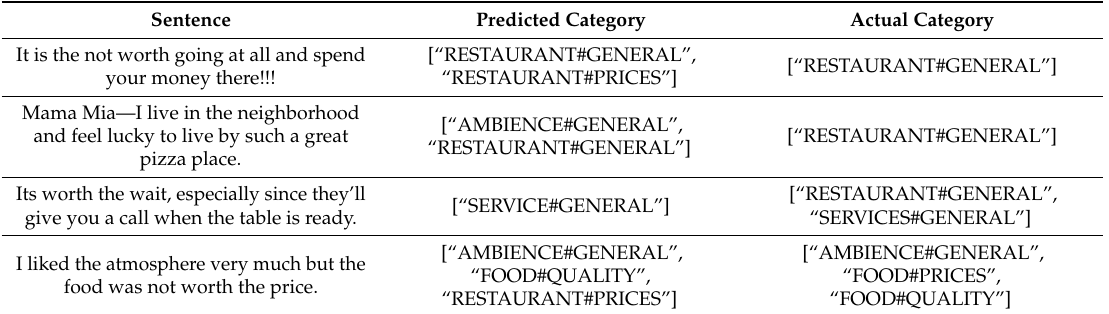
Table 12. Annotation